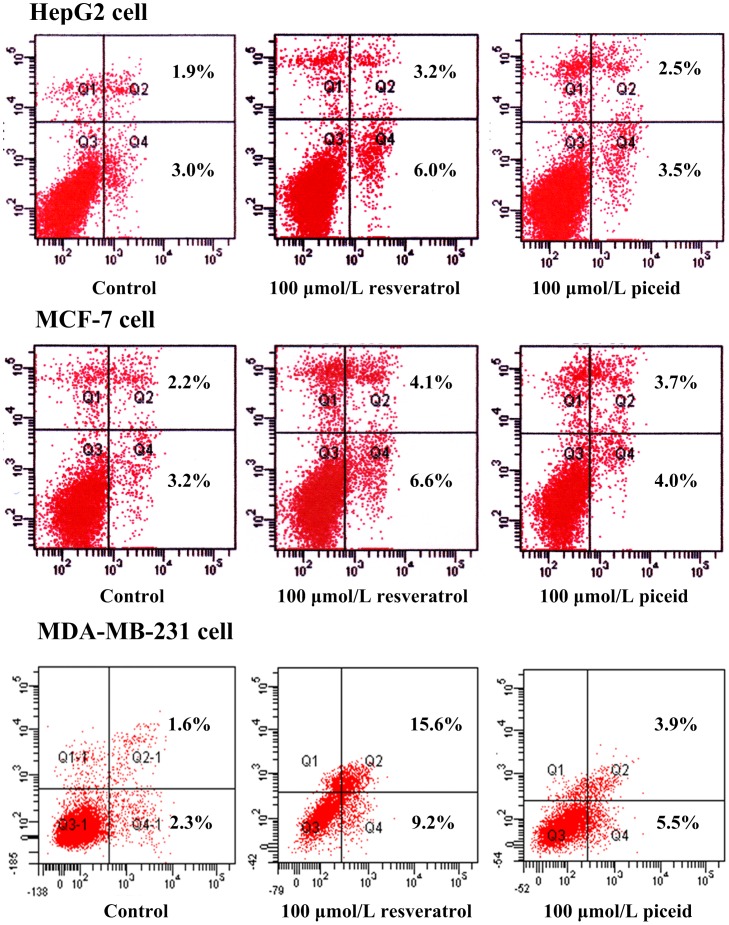
Tumor cells apoptosis induced by resveratrol and piceid.Cultures of HepG2 cells, MCF-7 cells and MDA-MB-231 cells were treated with 100 µmol/L resveratrol and piceid for 48 h. Cells were harvested by trypsinization and centrifugation, then analyzed in a Becton Dickinson FACScan (excitation at 488 nm) equipped with Cell Quest software after staining with annexin V-FITC and propidium iodide. Results shown are of an experiment representative of apoptosis.